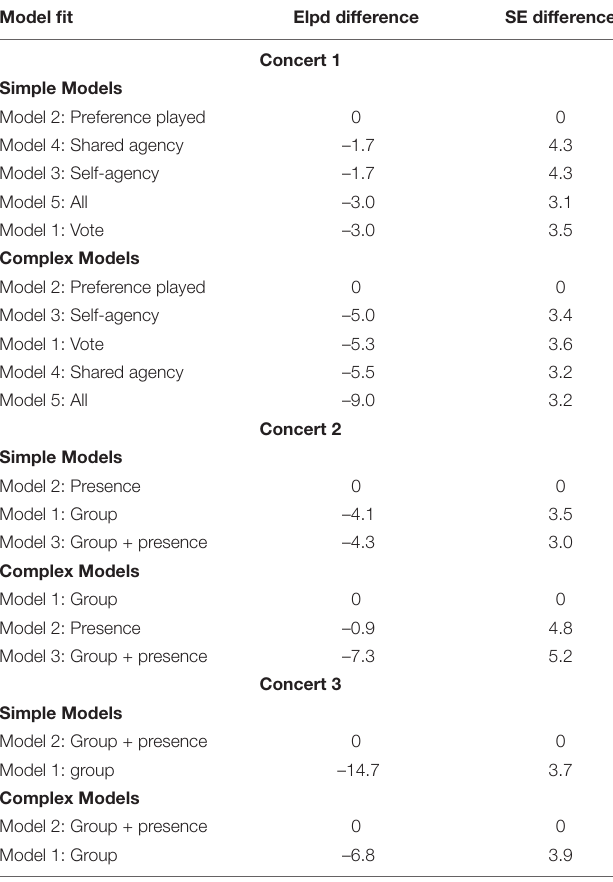
TABLE 3 | Concert 1 models and their predictive performance. Model fit Elpd difference SE